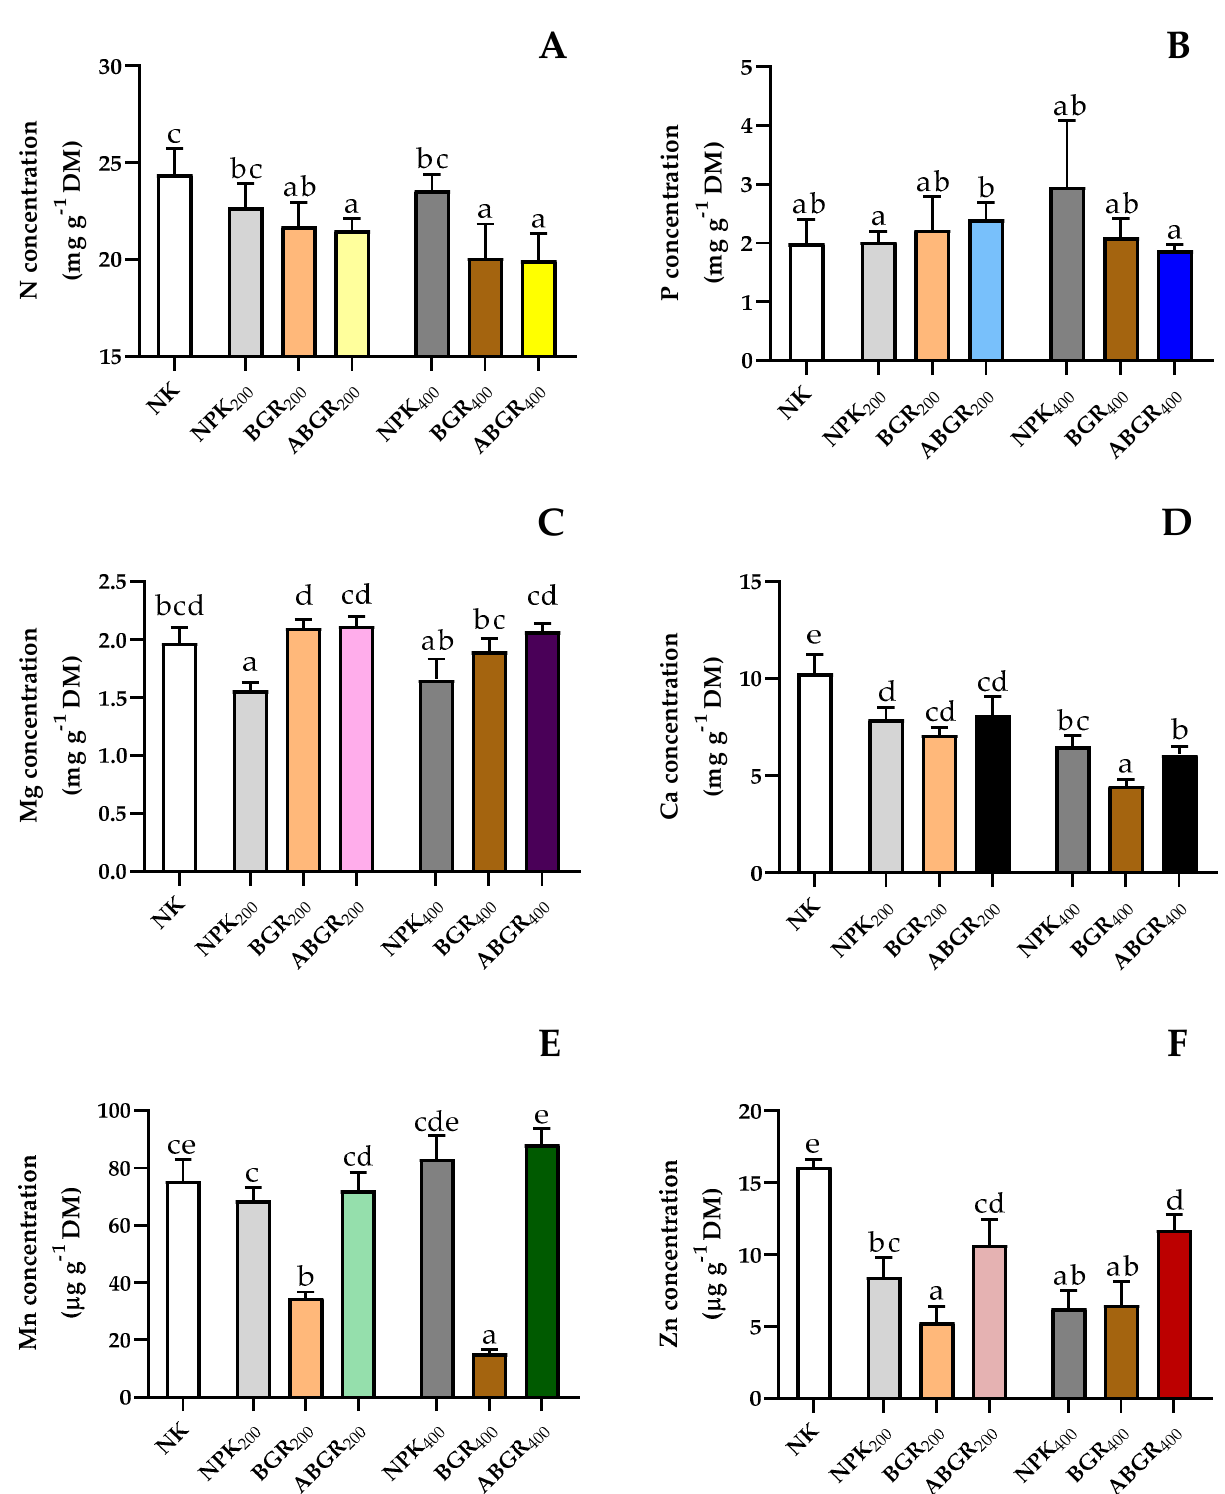
Figure 3. Concentrations of ( A ) N, ( B ) P, ( C ) Mg, ( D ) Ca, ( E ) Mn, and ( F ) Zn of 8 week old maize shoots. Values are the means ( n = 5) ± SD (bars). For treatment abbreviations, see Table 1. Different letters above the bars indicate significant differences ( p ≤ 0.05) between treatments.